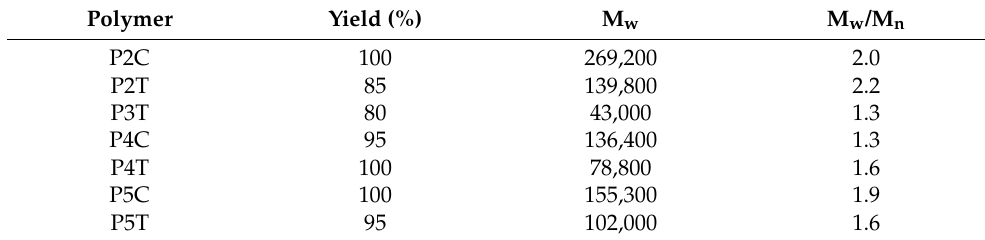
Table 1. GPC 1 data of N -Boc-protected